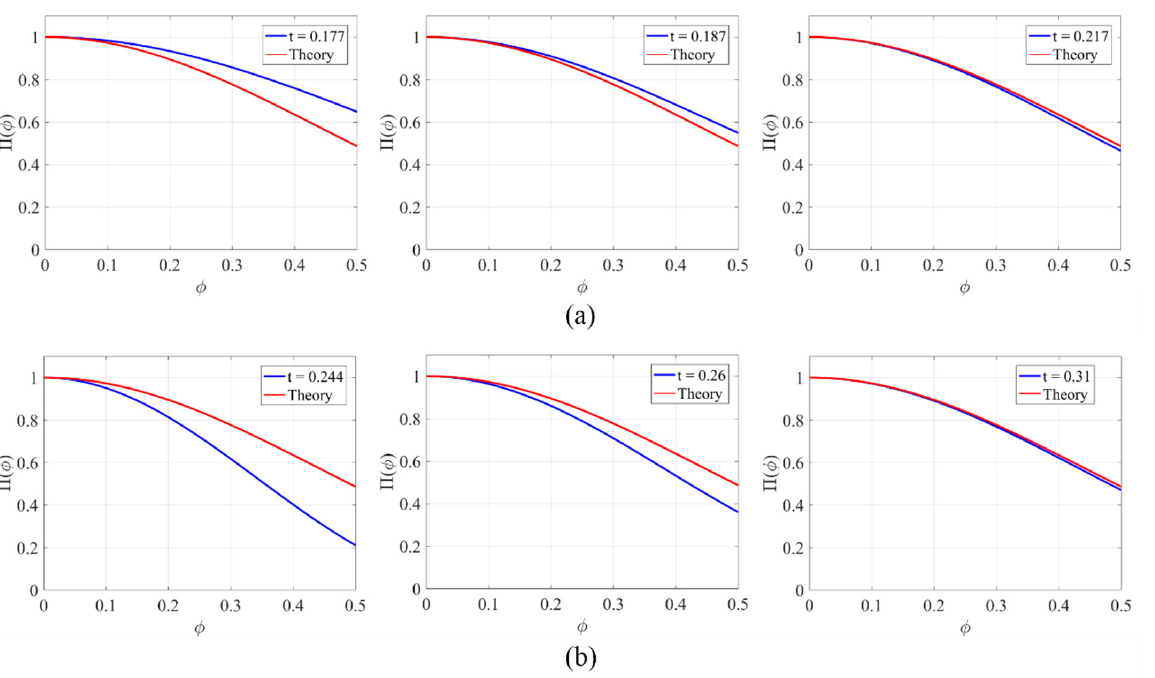
Figure 12. Evolution of Π ( φ ) of the AE activity, ( a ) critical time 2 (black circles— t crit2 = 0.217) and ( b ) critical time 3 (black stars— t crit3 = 0.31).